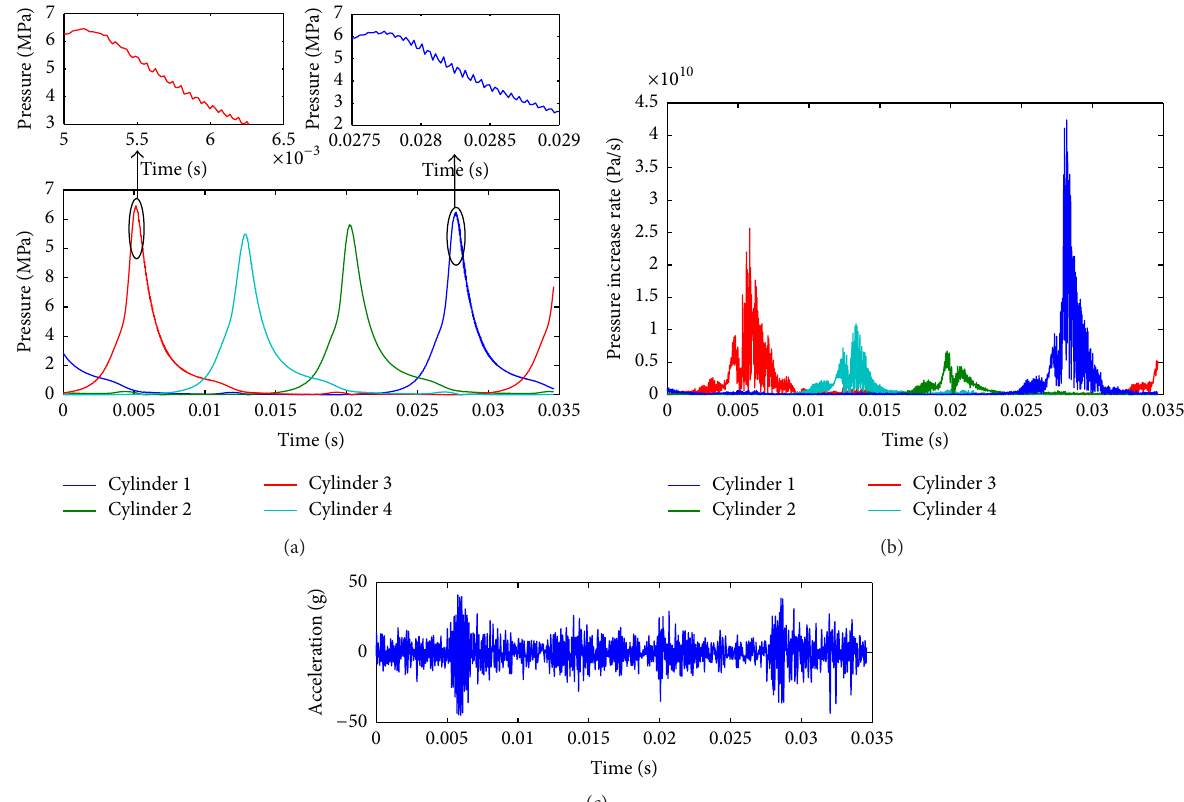
Figure 8: (a) Cylinder pressure signal. (b) Cylinder pressure increase rate. (c) Cylinder block vibration